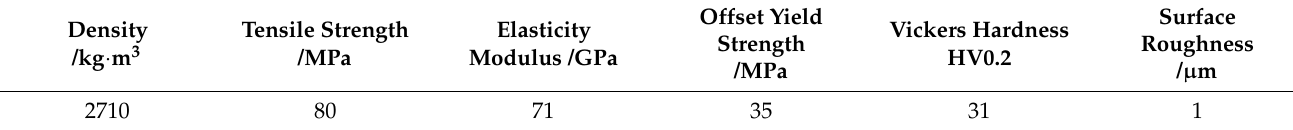
Table 3. Physical properties of the